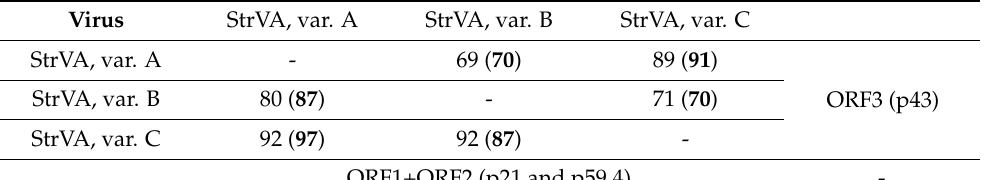
Table 2. Percentages of conserved nucleotide and amino acid (bold in parentheses) identities of StrVA’s ORFs and putative protein between viral variants coinfecting the 1/2017 strawberry plant. Virus StrVA, var. A StrVA, var. B StrVA, var. C StrVA, var. A - 69 ( 70 ) 89 ( 91 ) ORF3 (p43)StrVA, var. B 80 ( 87 ) - 71 ( 70 ) StrVA, var. C 92 ( 97 ) 92 ( 87 ) - ORF1+ORF2 (p21 and p59.4) -